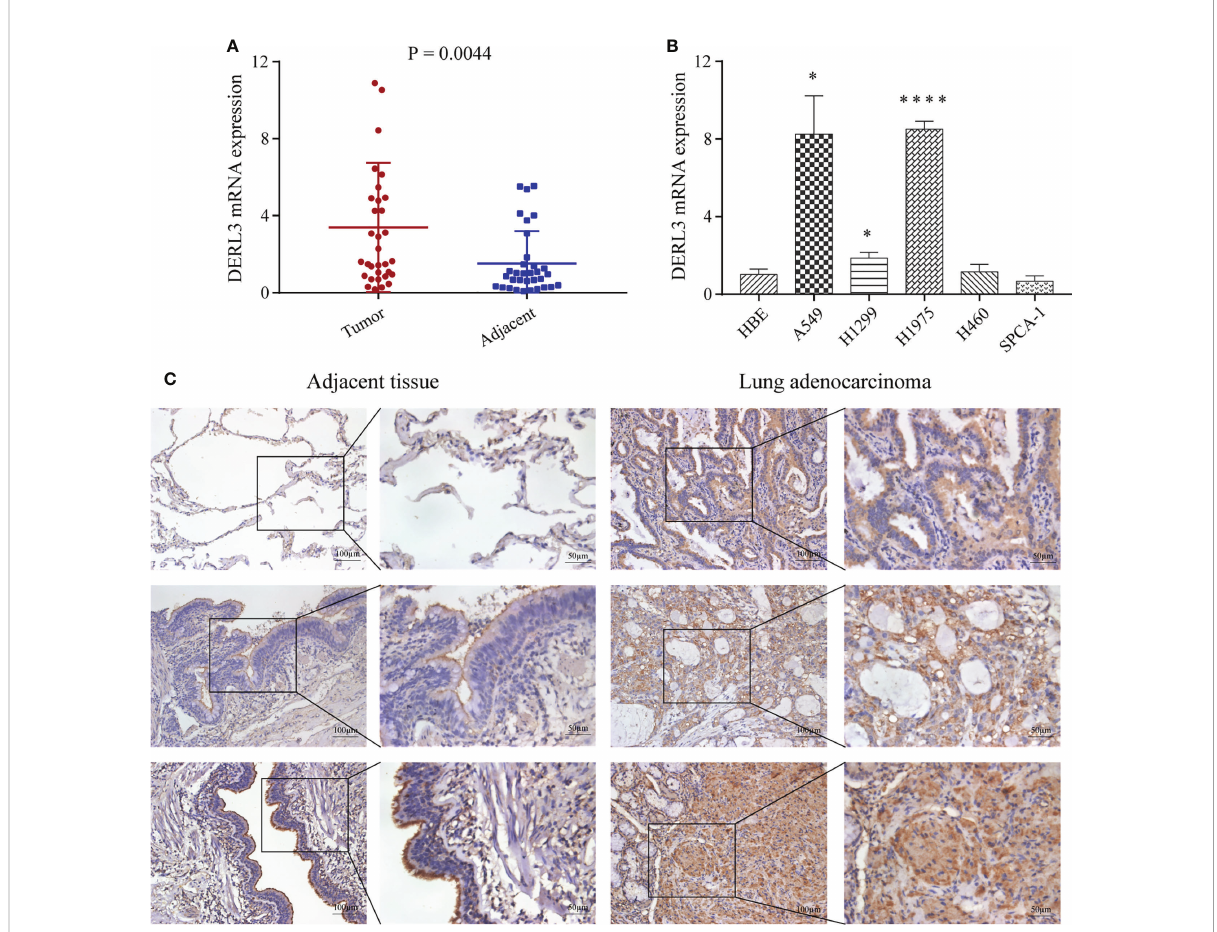
FIGURE 6 Identi fi cation of DERL3 expression in LUAD. (A) The mRNA expressions of DERL3 in LUAD tissues compared with adjacent tissues via RT-qPCR. (B) Detection of DERL3 expression in the normal pulmonary epithelial cell and LUAD cell lines by RT − qPCR. (C) Relative protein expression of DERL3 in LUAD tissues compared with adjacent non − tumor tissues with immunohistochemistry. (*p < 0.05, ****p <